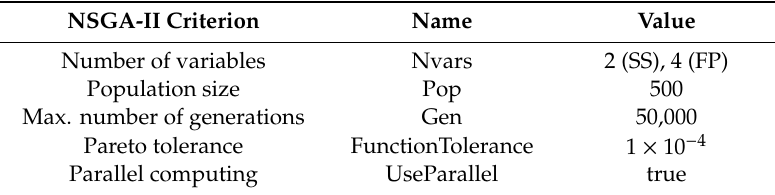
Table 5. Pareto optimization criteria for Example 2: ECR.